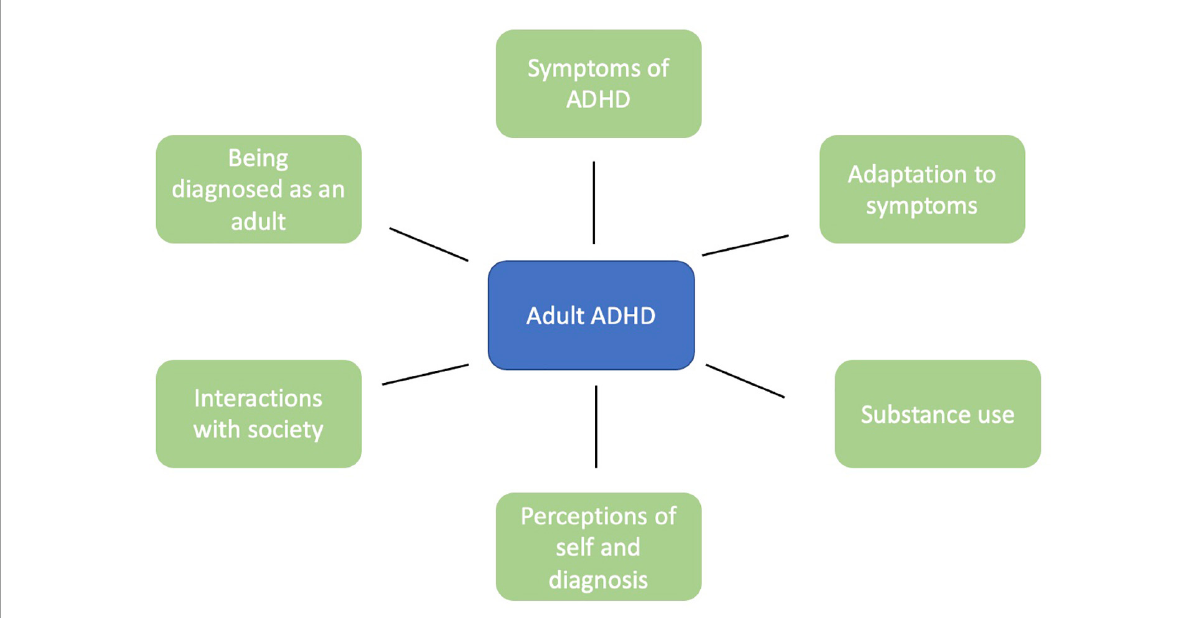
FIGURE2 Schematic diagram of the domains of features linked to the lived experiences of adults with